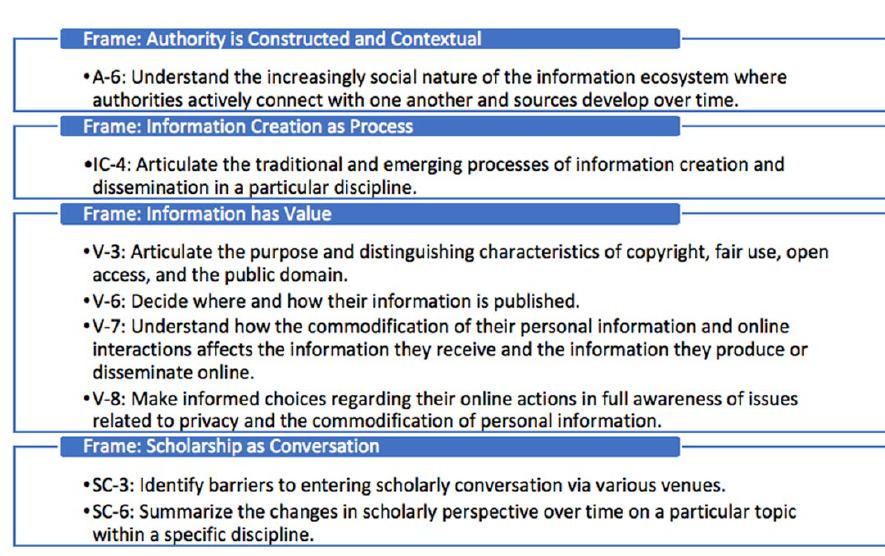
Figure 4 ACRL knowledge practices that did not map to the